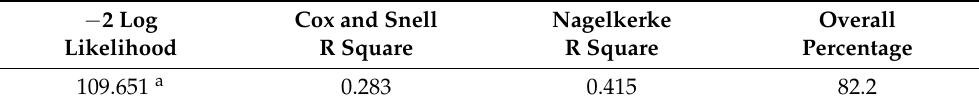
Table 3. Summary of the logistic regression model. − 2 Log Likelihood